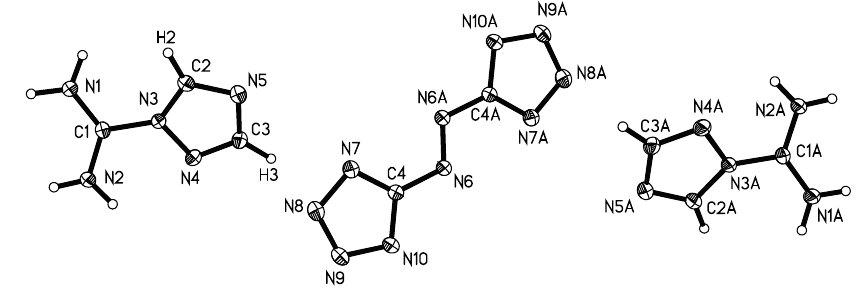
Figure 7. Molecular structure of 2 in the crystal, showing the atom-labeling scheme. Displacement ellipsoids are drawn at the 50% probability level. Selected bond lengths (Å) and angles (°): C(4)–N(6) 1.4042(18), C(4)–N(7) 1.3334(19), C(1)–N(10) 1.3344(18),